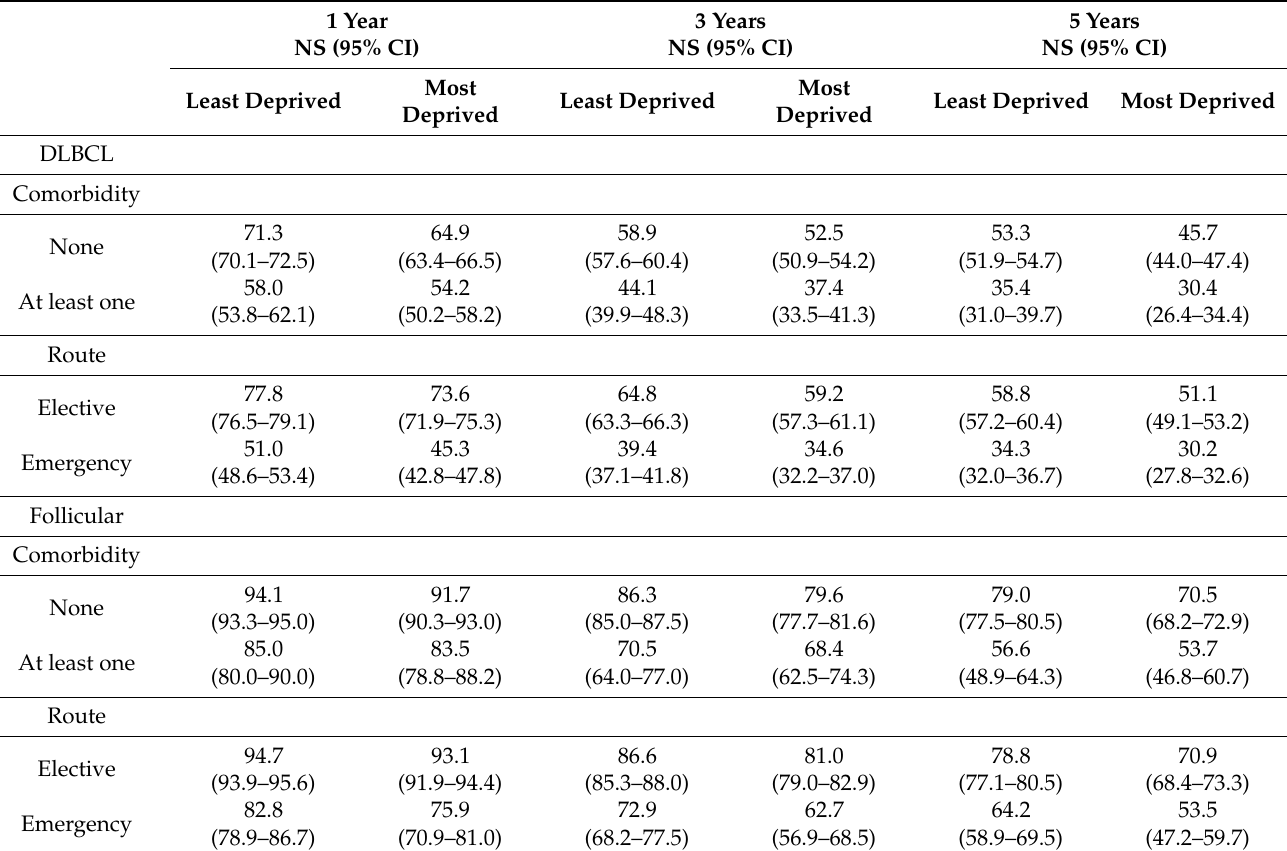
Table 2. Net survival estimates by comorbidity status and diagnostic route amongst patients diag- nosed with DLBCL ( n = 27,379) or FL ( n = 14,043) in England between 2005 and